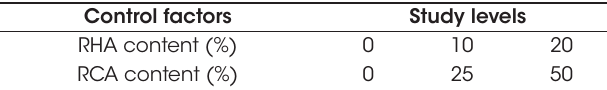
Factorial design used in this study. Factors and control levels (shrinkage, absorption rate, capillary porosity, total